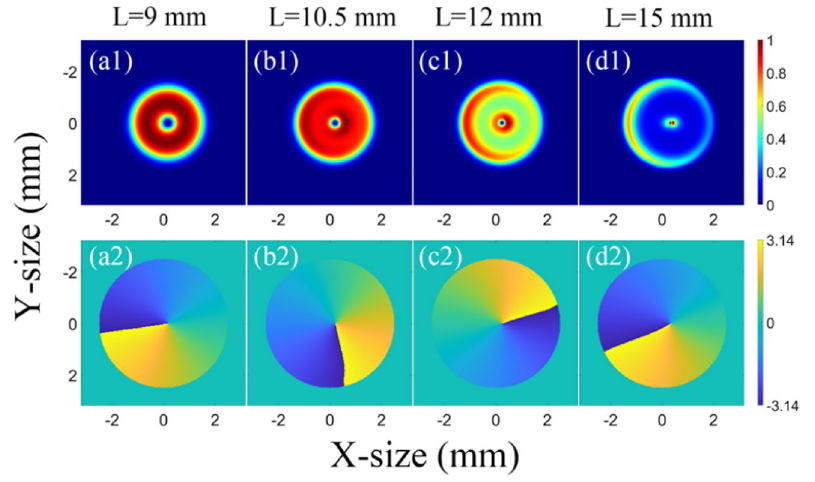
Figure 6. ( a ) Intensity distribution ( a1 – d1 ) and phase distribution ( a2 – d2 ) of amplified beams at different crystal lengths in non-collinear OPA.